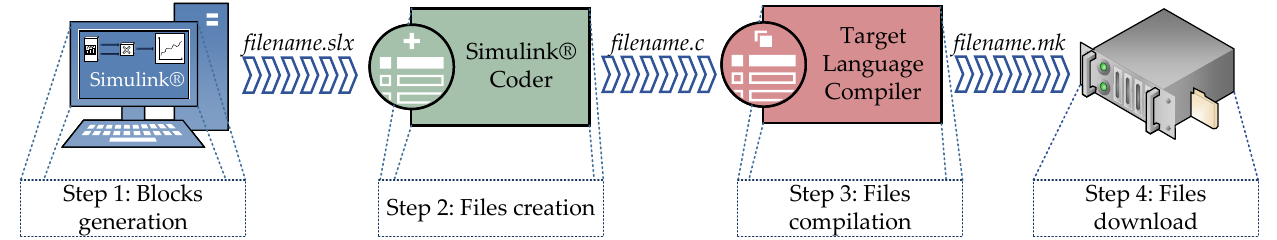
Figure 3. Code generation process using Simulink